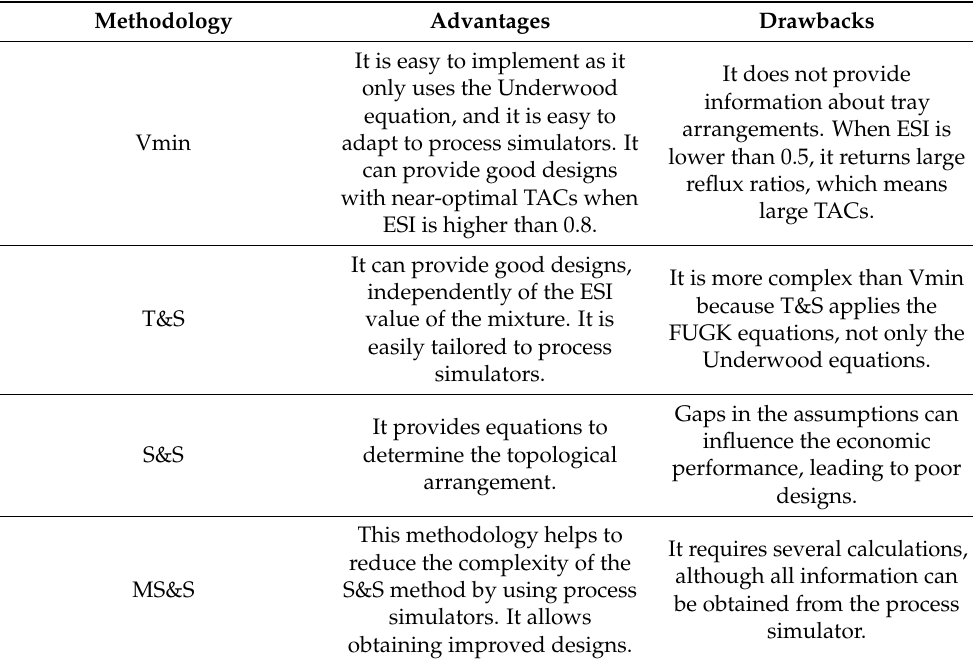
Table 8. Advantages and disadvantages of investigated